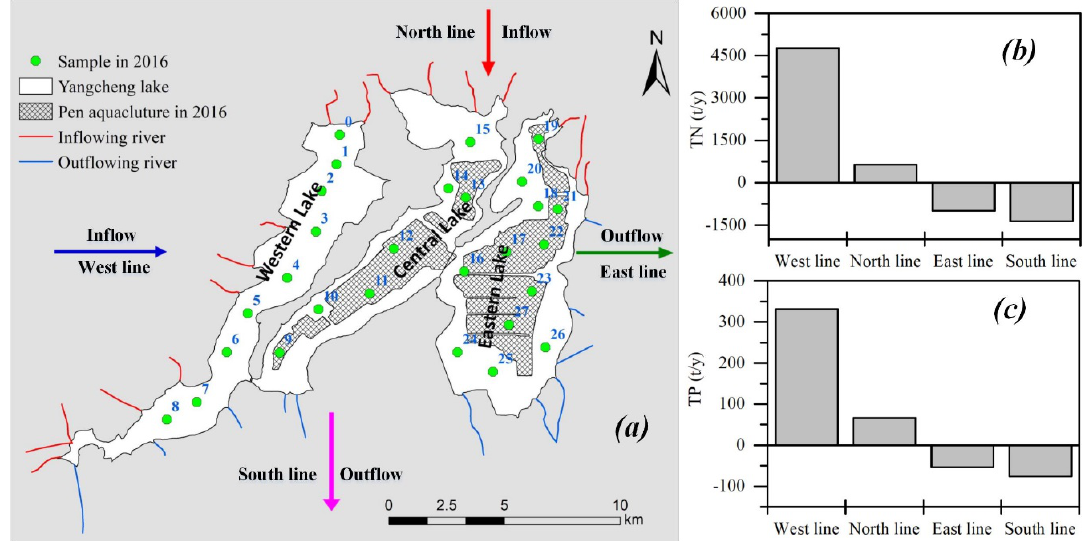
Figure A4. Distribution map of samples and pens in 2016 and inflowing and outflowing rivers ( a ); the amounts of inflowing or outflowing TN ( b ) and TP ( c ) in the West, North, East and South lines in 2016. A positive value represents the inflowing amount of TN or TP, and a negative value is the outflowing amount of TN or TP.